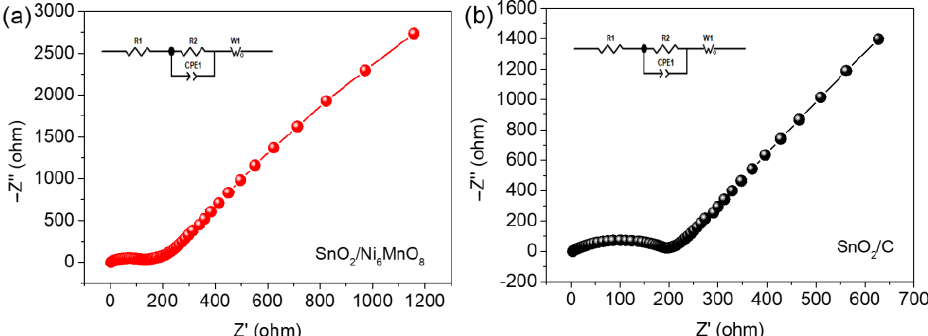
Figure 8. Cyclic voltammetry (CV) curves for Na 6 MnO 8 at a scanning rate of 0.1 mV g −1 .